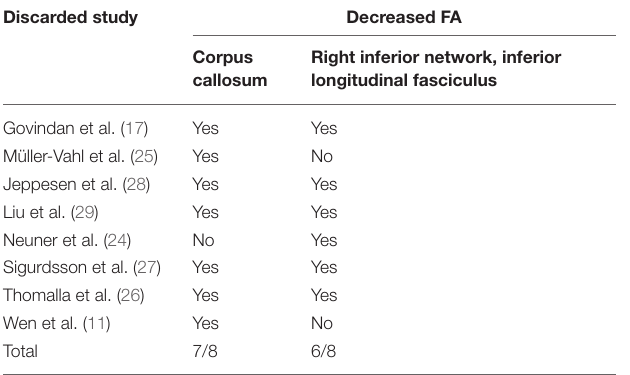
TABLE 5 | Results of jackknife analysis in all included studies.